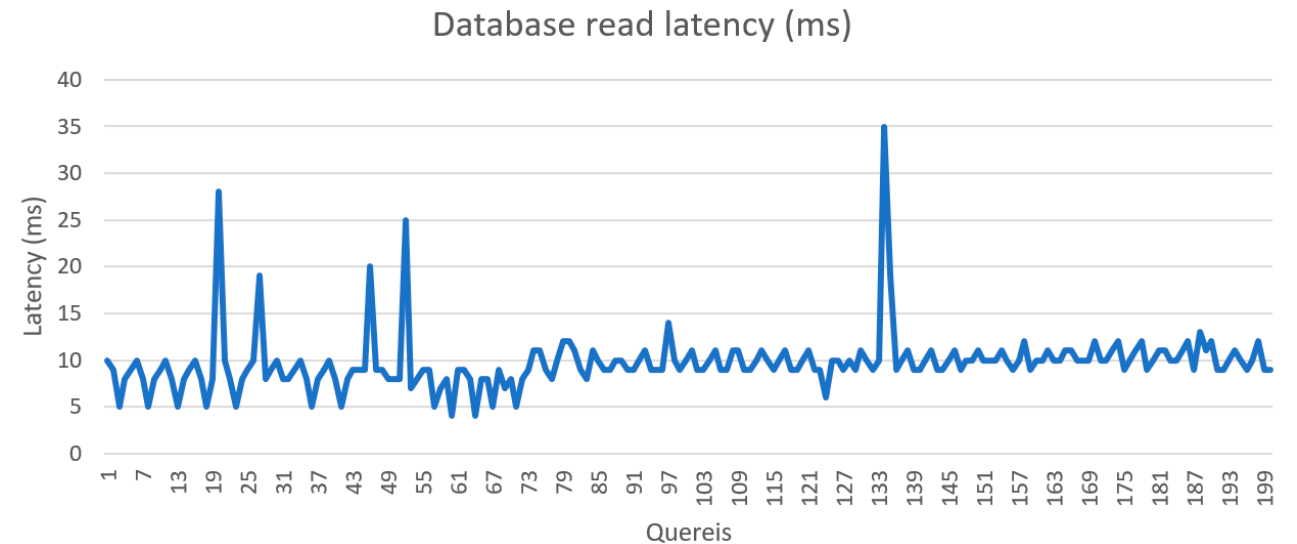
Figure 28. Comfort conditions in the 15 social housing units in winter.